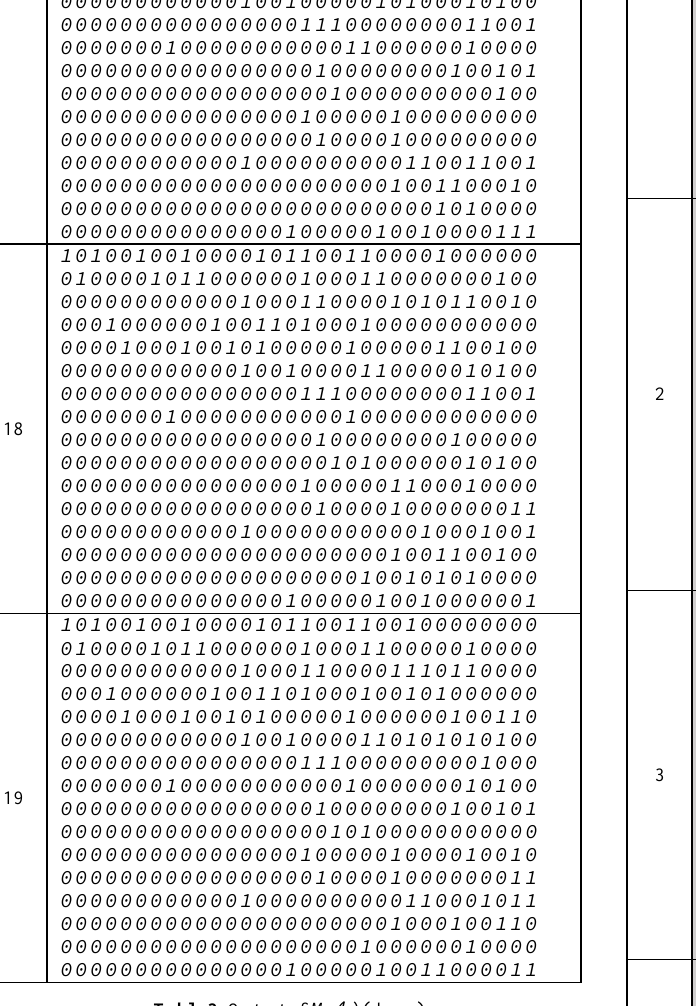
Table 3 : Output of M d (h) (above). From Table 3, we convert M d (h) into row ladder matrix - M d (h)* using Gaussian elimination. For this purpose, we are using Maple